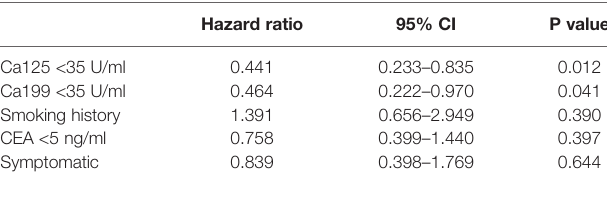
TABLE 2 | Multiple analysis of PFS in PASC